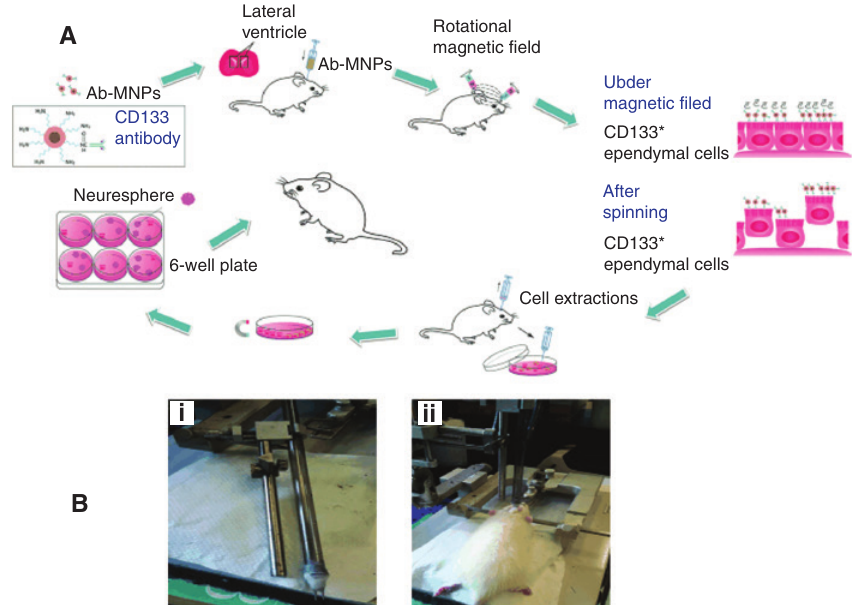
Figure 2: Extraction of neural stem cells from live rat brain by MNPs. (A) Neural stem cells (NSCs) could be isolated from an adult rat after injecting the CD133-modified MNPs into the subventricular zone of the brain. NSCs bound to MNPs on the endothelial lines dissociate and enters the cerebrospinal fluid under an external spinning magnetic field. NSCs bound to MNPs can be extracted either using a microsyringe or NdFeB magnetic probe needle. (B) Photographic images of (i) magnetic probe and (ii) micro-surgery (Reproduced with the permission of the publisher, John Wiley and Sons, Copyright 2013, from Ref. [34]).